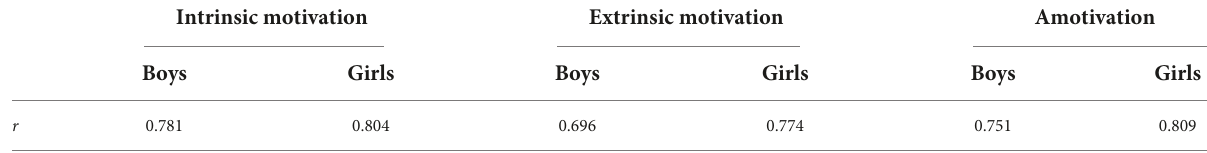
TABLE 2 Correlation between the motivation types and academic performance of research participants (averaged values).